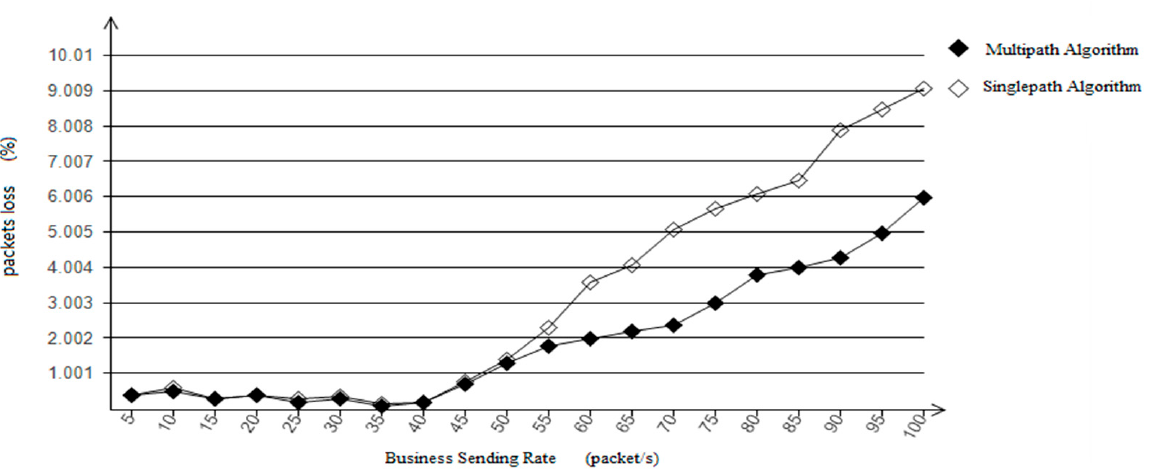
Figure 9. Packets loss comparison chart.